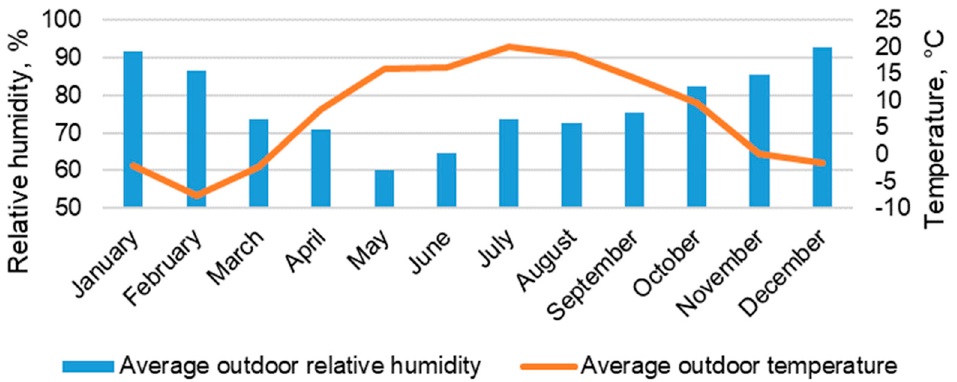
Figure 8. The monthly average outdoor relative humidity and temperature (data from the weather station “Skriveri”).